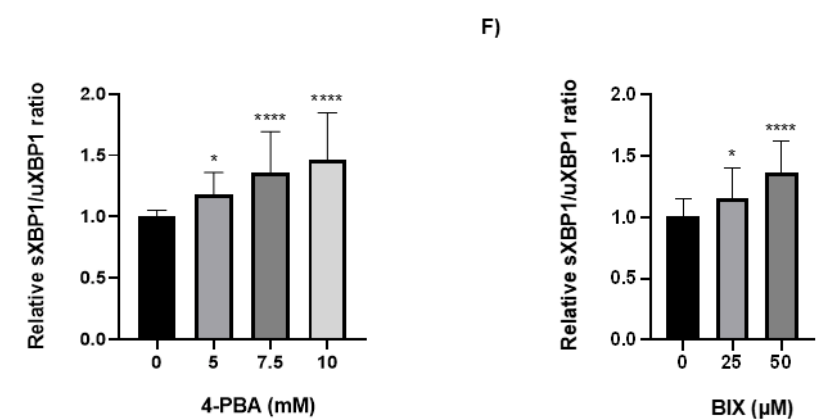
Figure 4. The effect of chaperone treatment on the ER folding machinery. ( A ) Representative Western blot analysis (cropped image adjusted for brightness/contrast) of lysates from cells treated with 4-PBA for the detection of BiP and GRP94. β -actin was used as loading control. ( B ) Densitometric analysis of bands from ( A ), representing BiP or GRP94 normalized to β -actin. ( C ) Representative Western blot analysis (cropped image adjusted for brightness/contrast) of lysates from cells treated with BIX for the detection of BiP and GRP94. β -actin was used as loading control. ( D ) Densitometric analysis of bands from ( C ), representing BiP or GRP94 normalized to β -actin. ( E , F ) mRNA levels of sXBP1 and uXBP1 were assessed by SYBR green qRT-PCR. Quantitation was performed using the comparative CT method with 18S as the endogenous control gene and untreated cells as the calibrator. Values are shown as mean ± SD of fold change relative to untreated cells from three independent experiments. **** p ≤ 0.0001, * p ≤ 0.05 (one-way